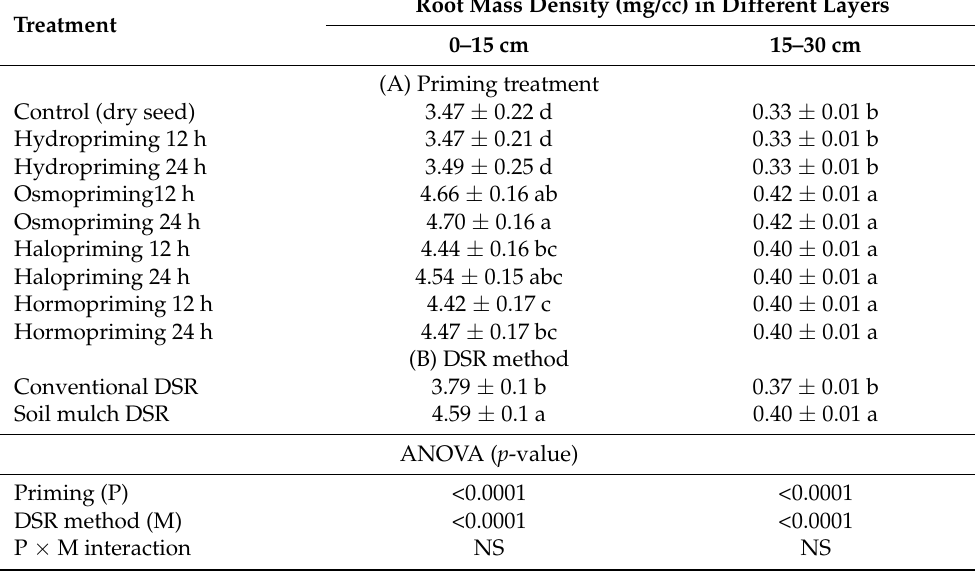
Table 7. Root mass density of rice under different seed priming techniques and DSR establishment methods during 2019 at Ludhiana, India.